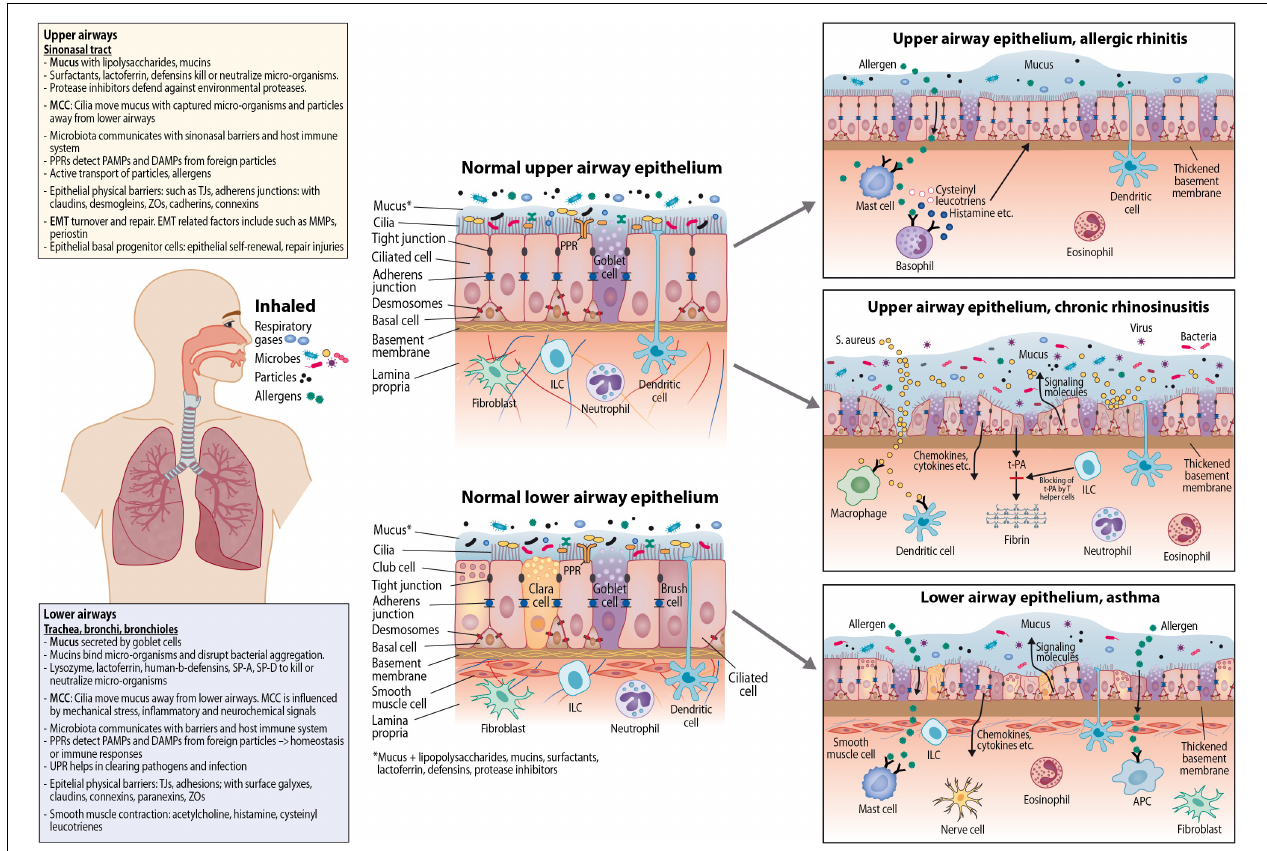
FIGURE 1 | Epithelial dynamics in upper and lower airway epithelium; normal epithelium and epithelium in allergic rhinitis, chronic rhinosinusitis, and asthma. APC, Antigen-presenting cell; ILC, innate lymphoid cell; PPR, pattern recognition receptor; PAMP, pathogen-associated molecular pattern; DAMP, danger-associated molecular pattern; MCC, mucociliary clearance; TJ, tight junction; t-PA, tissue plasminogen activator; ZO, zonula occludin; EMT, epithelial-mesenchymal transition; MMP, matrix metalloproteinase; SP, surfactant protein; UPR, unfolded protein